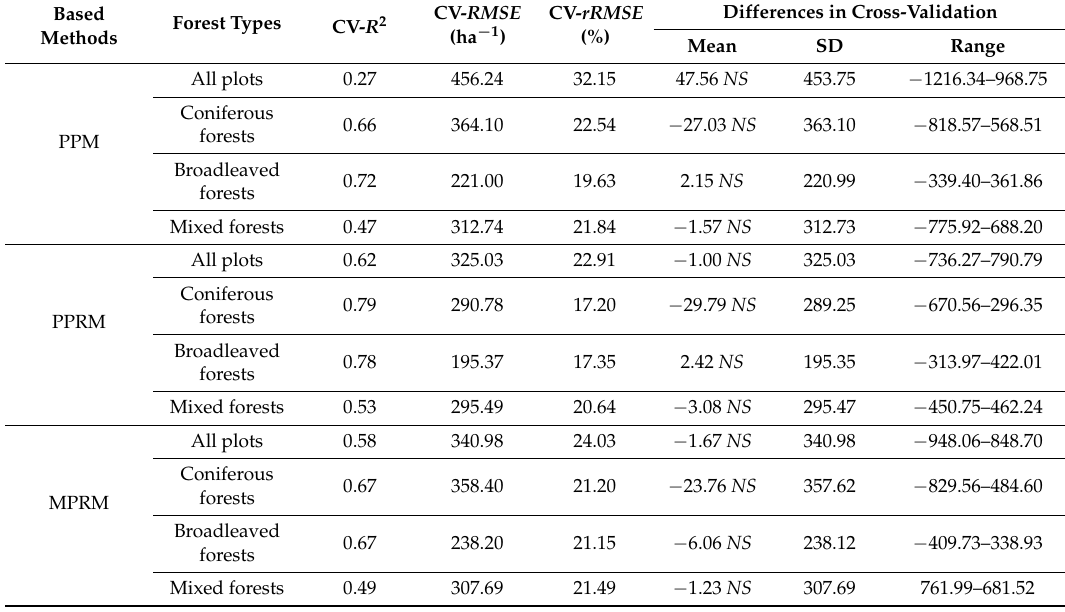
Table 6. The statistical results of the cross-validation for stem density estimations based on the methods of PPM, PPRM, and